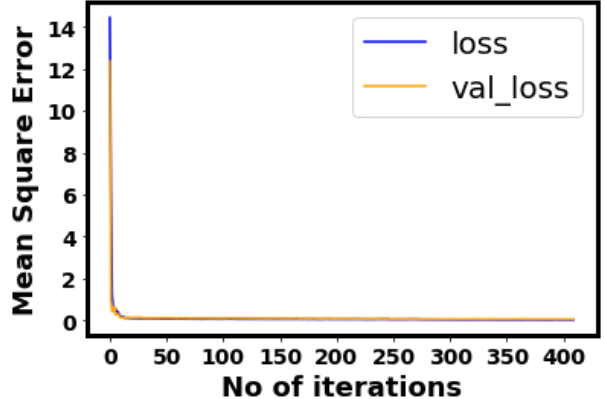
Figure 11. Training and validation losses’ minimization.